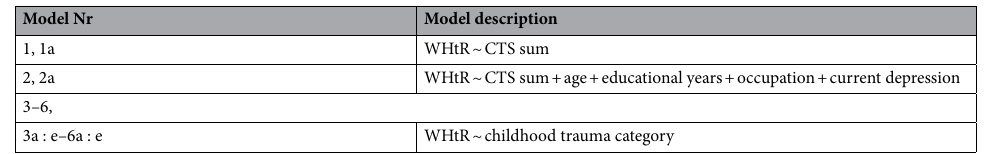
Table 2. Overview of models used in the following analysis. 1 – 6 = baseline, 1a – 6a = follow-up. Models b – e are used in the sensitive analysis.